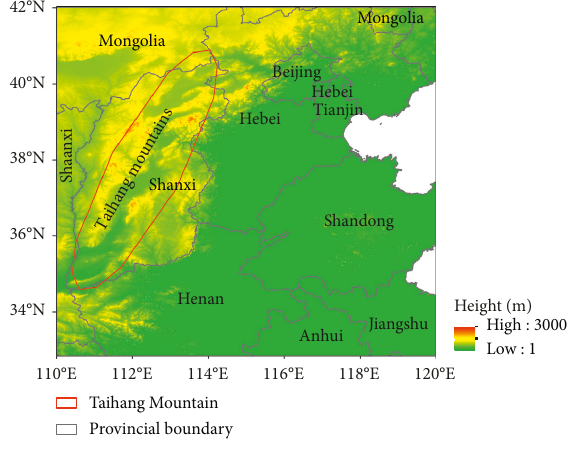
Figure 1: Map of the study